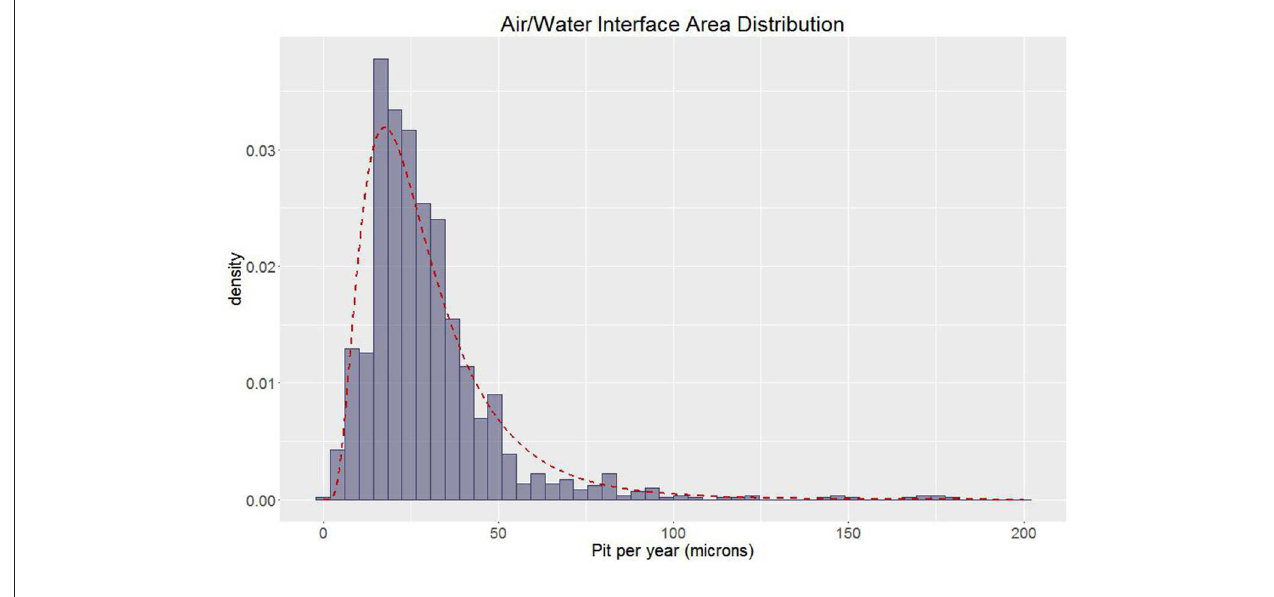
FIGURE 6 | Corrosion depth distribution at air/water interface (section A).